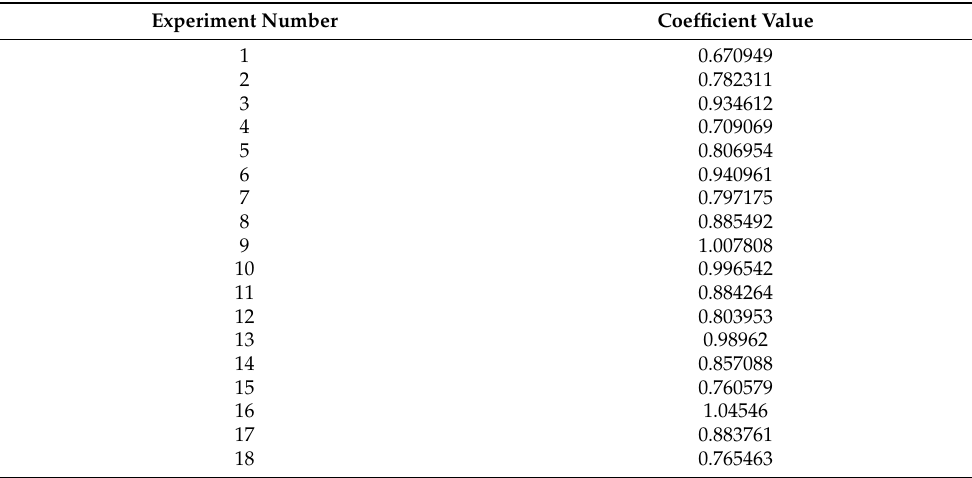
Table 11. The predictive evaluation functional model